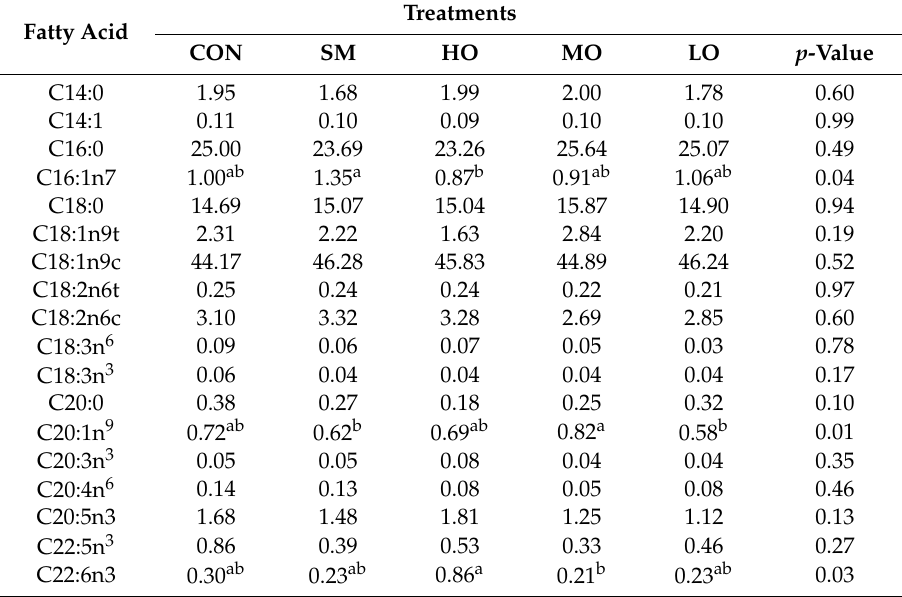
a,b Di ff erent superscripts mean significant di ff erence ( p < 0.05) among treatments